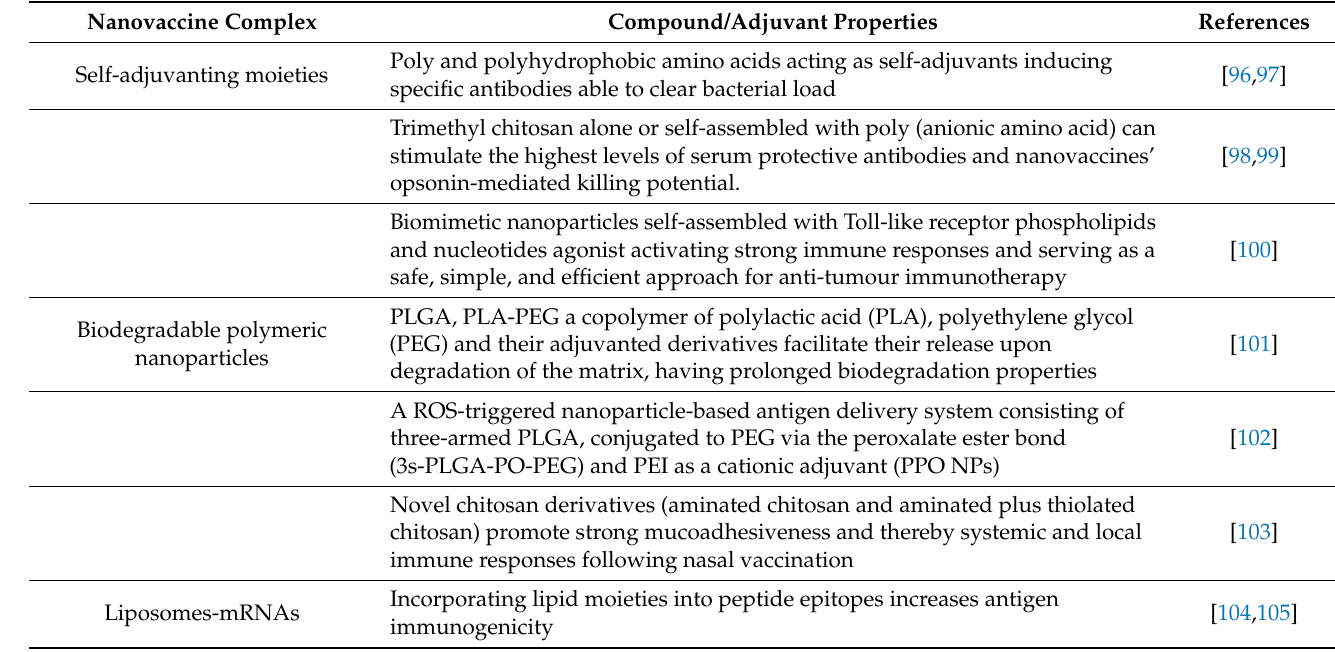
Table 2. Some ultimate effective options enhancing nanoscale adjuvanticity and delivery. Nanovaccine Complex Compound/Adjuvant